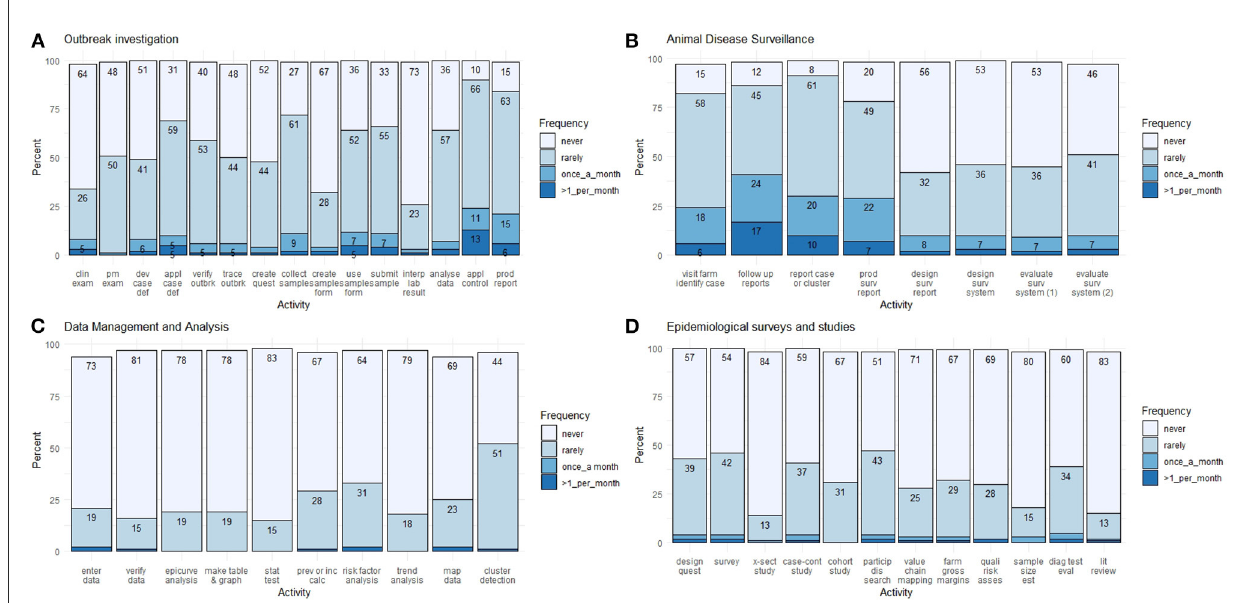
FIGURE1 Percentage frequency distribution of respondent’s activity regarding outbreak investigation (A) , animal disease surveillance (B) , data management and analysis (C) and epidemiological surveys and studies (D) from an online veterinary epidemiology capacity cross-sectional study in Lao PDR between February and March 2021. The percentage may not sum to 100 due to rounding. Key labels on the x-axis: clin, clinical; pm, post-mortem; def, definition; quest, questionnaire; interp, interpret; surv, surveillance; prev, prevalence; inc, incidence; calc, calculation; X-sect, cross-sectional; particip, participatory; Quali, Qualitative; asses, assessment; est, estimation; diag, diagnostic; eval, evaluation; lit, literature.